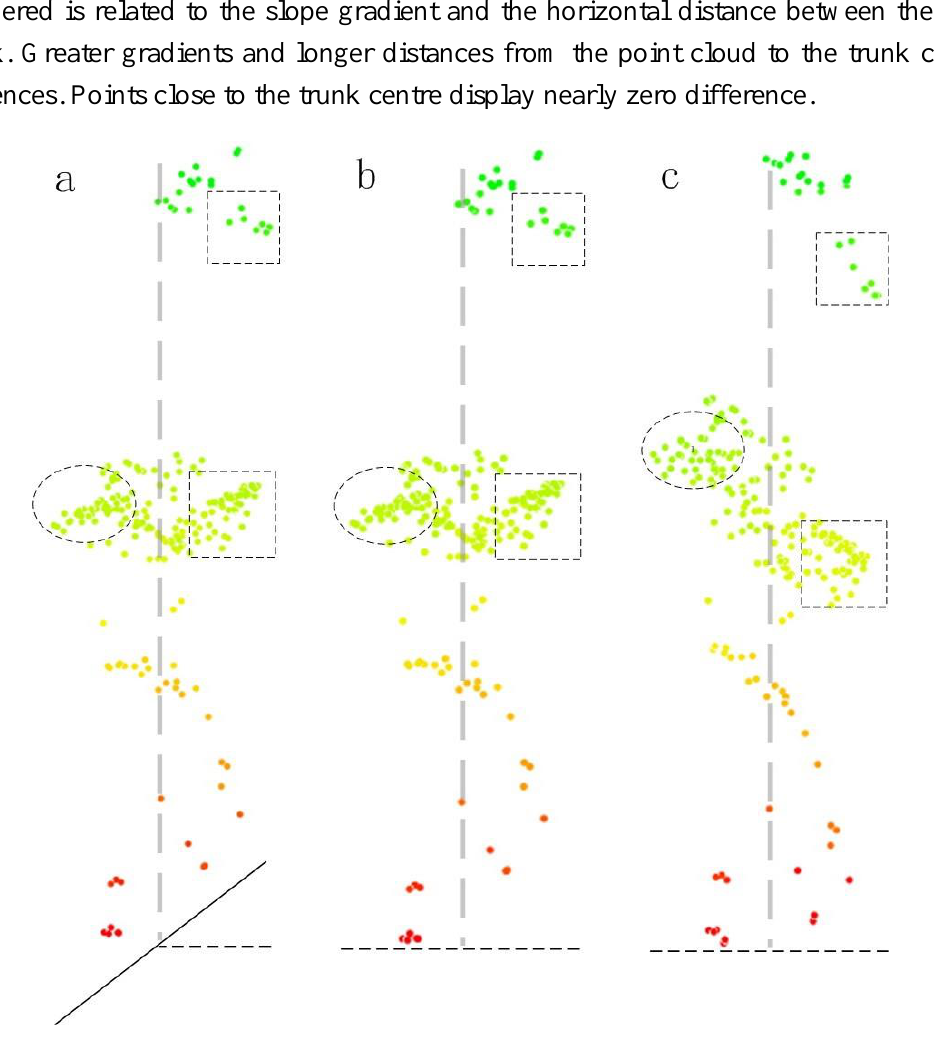
Figure 7. Point cloud of individual tree canopies: ( a ) raw point cloud; ( b ) new normalized point cloud; ( c ) normalized point cloud by a conventional